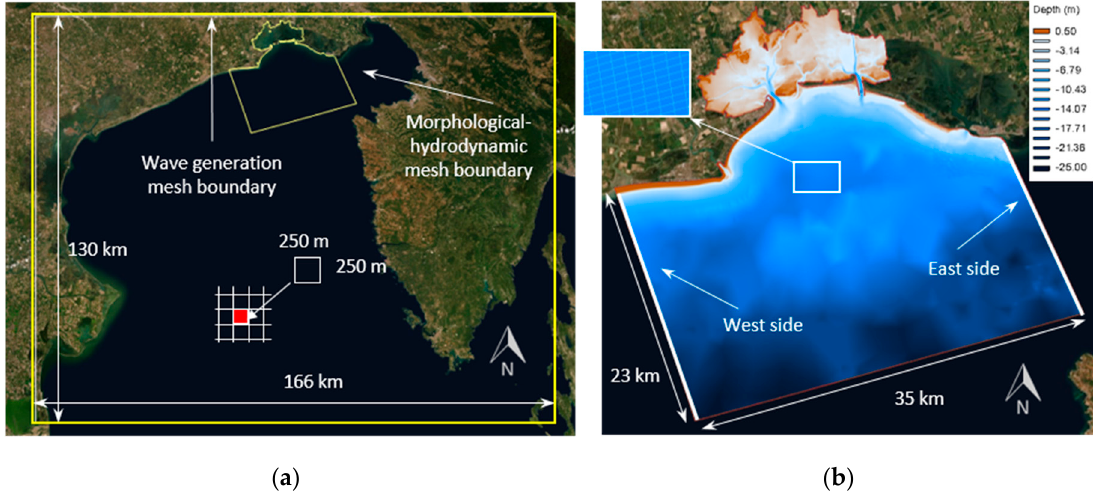
Figure 7. Computational domains: ( a ) the regular grid of the spectral model covering the northern Adriatic Sea; ( b ) the morphological-hydrodynamic mesh.